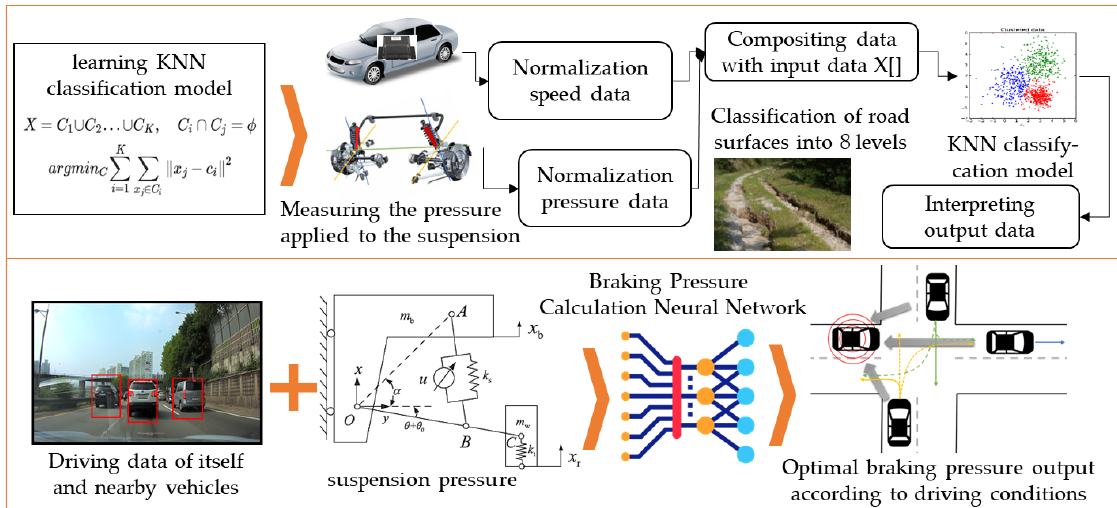
Figure 2. The structure of the RRCM.